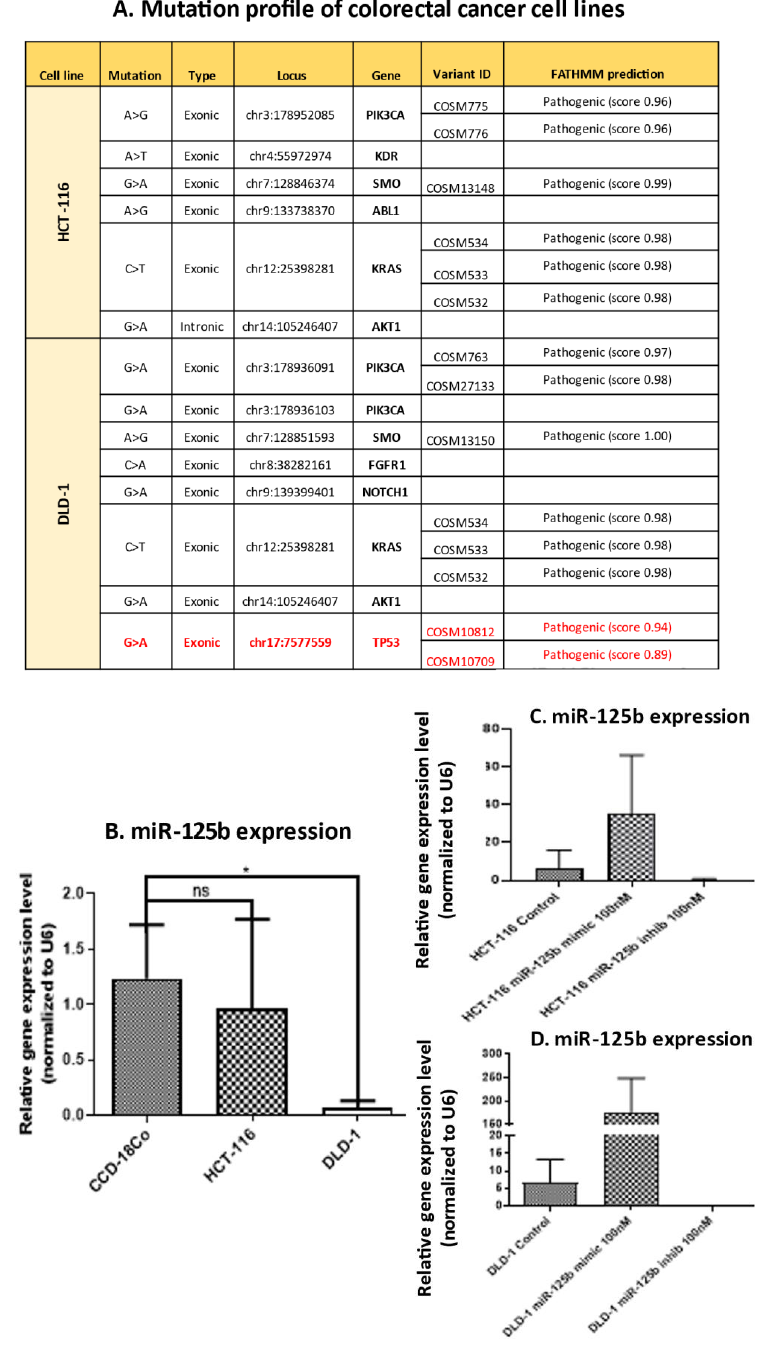
Figure 2. Establishment of functional in vitro model for miR-125b investigation in colon cancer. ( A ) Next-generation sequencing cancer panel results on HCT-116 and DLD-1 colon cancer cell lines. ( B ) RT-qPCR analysis for miR-125b-5p expression in colon cancer cell lines, HCT-116 and DLD-1, compared to normal cell line, CCD-18Co (normal colon fibroblasts) (data presented as mean ± S.D.; * p = 0.0161 for DLD-1, independent t -test compared to CCD-18Co). Experiments were performed in biological duplicates for each cell line and miR-125-5p relative expression was expressed by fold- change and normalized to U6 snRNA. ( C , D ). Validation of miR-125b mimic (100 nM) and inhibitor (100nM) transfection in HCT-116 cell line ( C ) and DLD-1 cell line ( D ) compared to control cell treated with empty Lipofectamine 2000 (data presented as mean ± S.D.). Experiments were performed in biological duplicates for each cell line and miR-125-5p relative expression was expressed by fold-change and normalized to U6